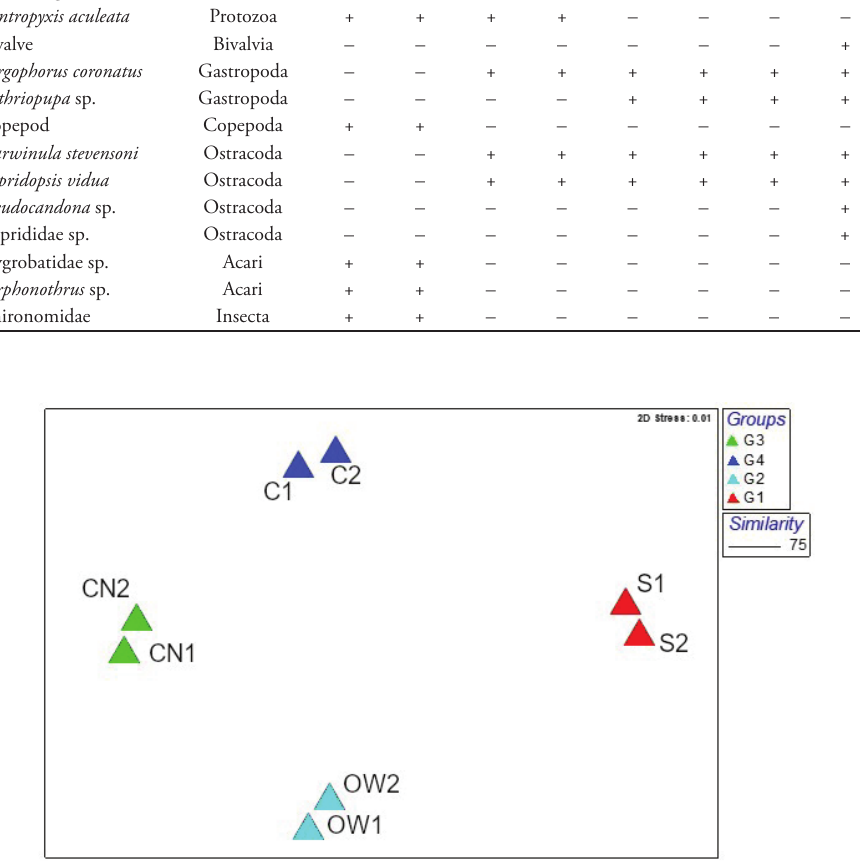
Figure 5. Non-metric multidimensional scaling plot based on Bray-Curtis index and squared root transformed abundance data of species from cenote X-Batún. Assemblage 1 (G1), assemblage 2 (G2), assemblage 3 (G3) and assemblage 4 (G4). Abbreviations are as follows: S – surface; OW – open water; CN – cavern; C – cave.